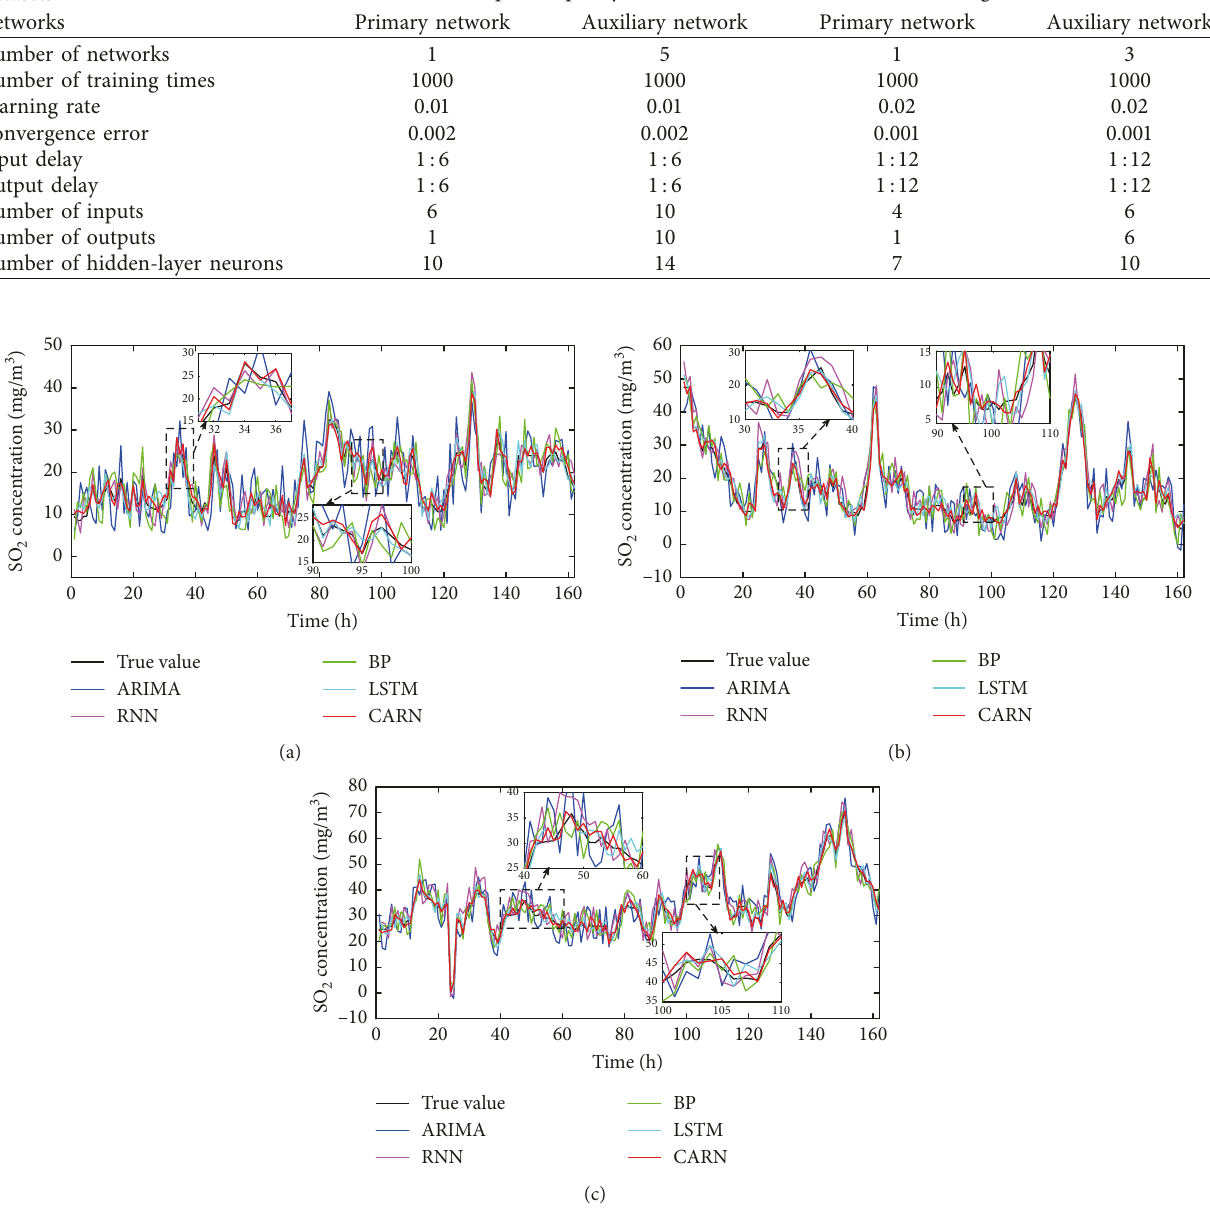
Figure 5: Prediction results of atmospheric quality data in three time periods: subset data (a) from June to August in 2016, (b) from September to November in 2016, and (c) from December in 2016 to February in 2017.